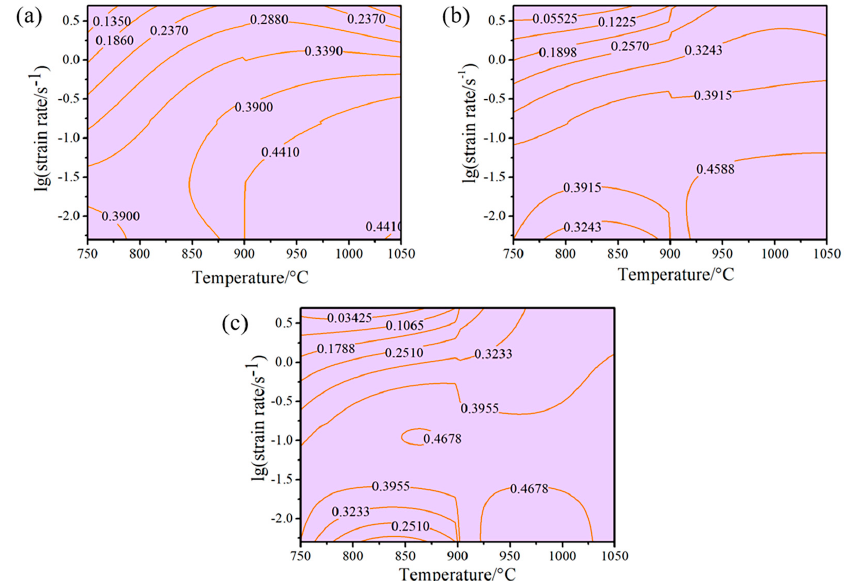
Figure 3. Two-dimensional power dissipation maps of Ti555211 sample at various strains: ( a ) 0.3; ( b ) 0.6; ( c ) 0.9.